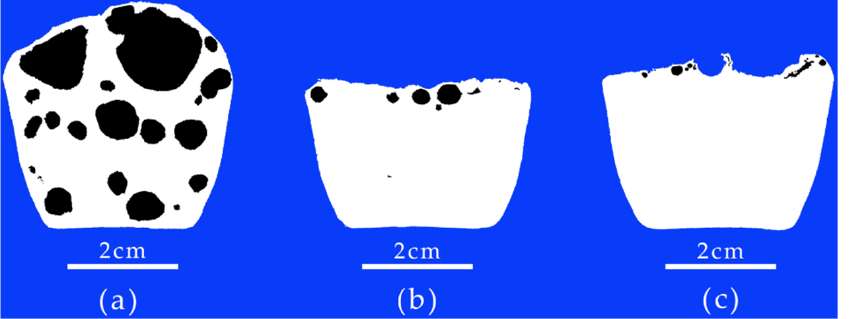
Figure 2. Pore size and content of Al-6Mg alloy melt solidified under reduced pressure after melt purification: ( a ) non-vacuum static melt treatment, ( b ) non-vacuum rotary-injection purification, ( c ) vacuum-stirring purification. Table 2. Ratio of pore area under different purification processes. Purification